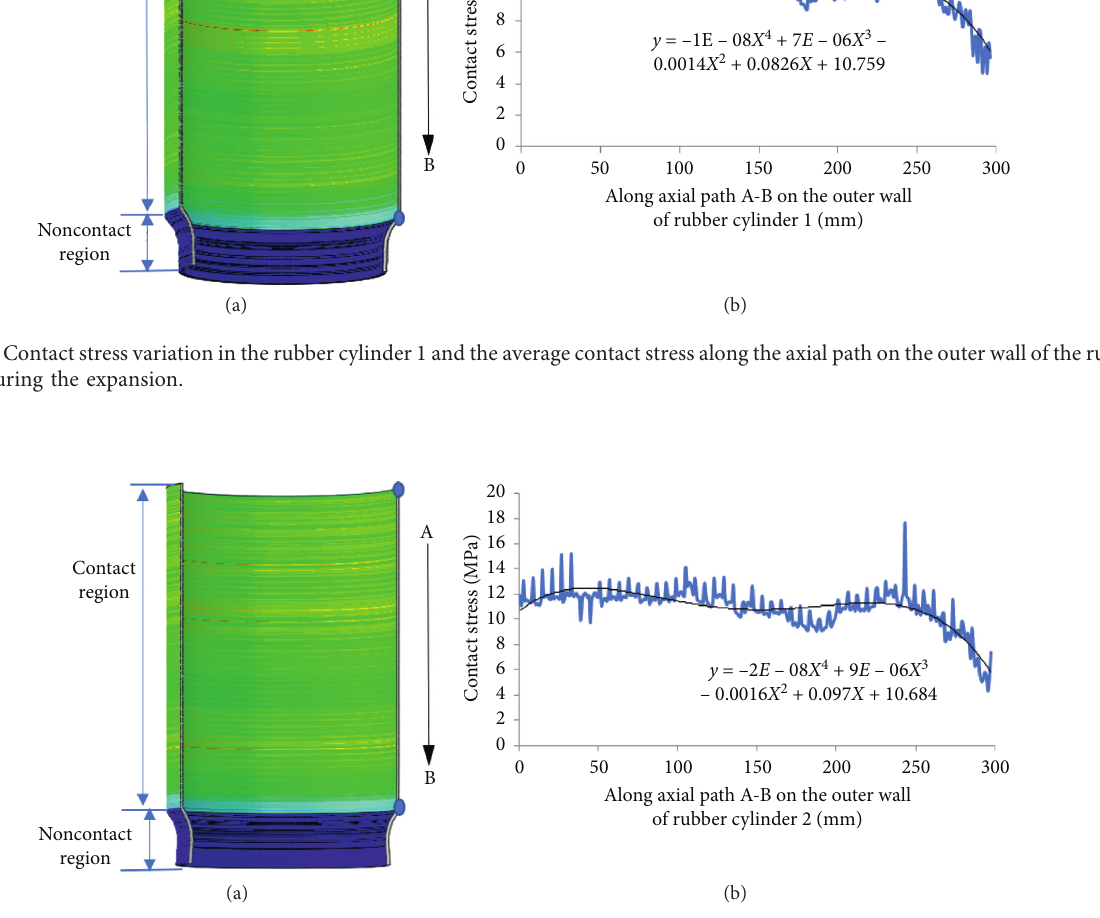
Figure 12: Contact stress variation in the rubber cylinder 2 and the average contact stress along the axial path on the outer wall of the rubber cylinder during the expansion.